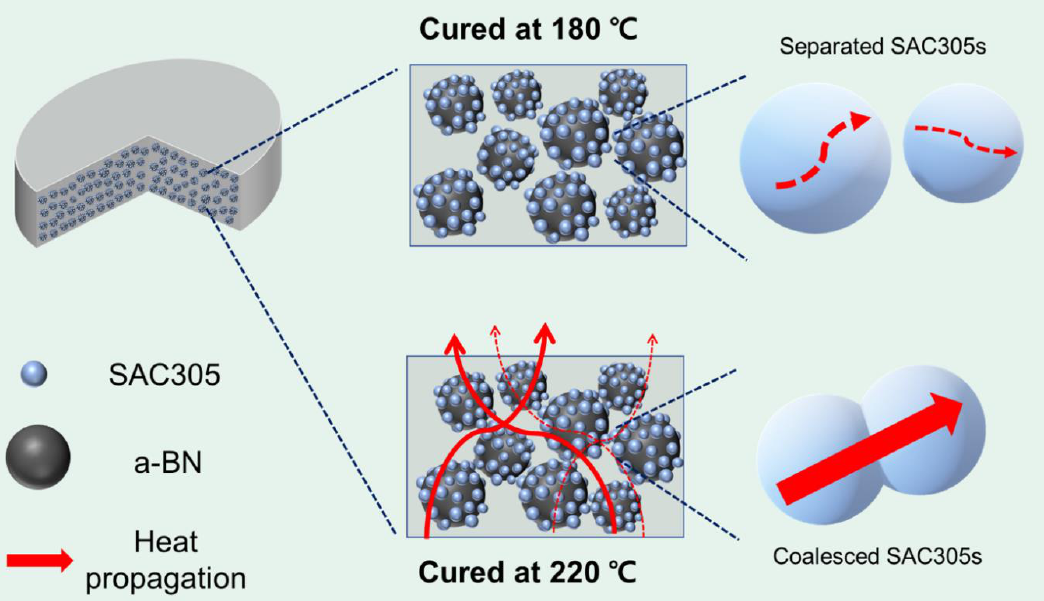
Figure 1. Schematic of fractured surface of the composites cured at 180 °C and 220 °C.